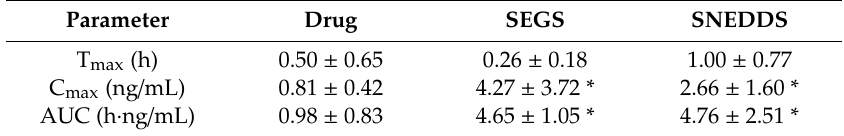
Figure 9. Mean plasma level-time profiles of PLAG after oral administration of drug alone, SEGS and SNEDDS at a dose equivalent to 50 mg / kg PLAG in rats. Each value designates the mean ± S.D. ( n = 6). The SEGS and SNEDDS were composed of PLAG / SLS / HPMC / calcium silicate / MCC at the weight ratio of 1:0.25:0.1:0.5:3. * p < 0.05 compared with drug only; # p < 0.05 compared with drug only and SNEDDS. Table 1. Pharmacokinetic parameters after oral administration of drug alone, SEGS and SNEDDS at a dose equivalent to 50 mg / kg drug in